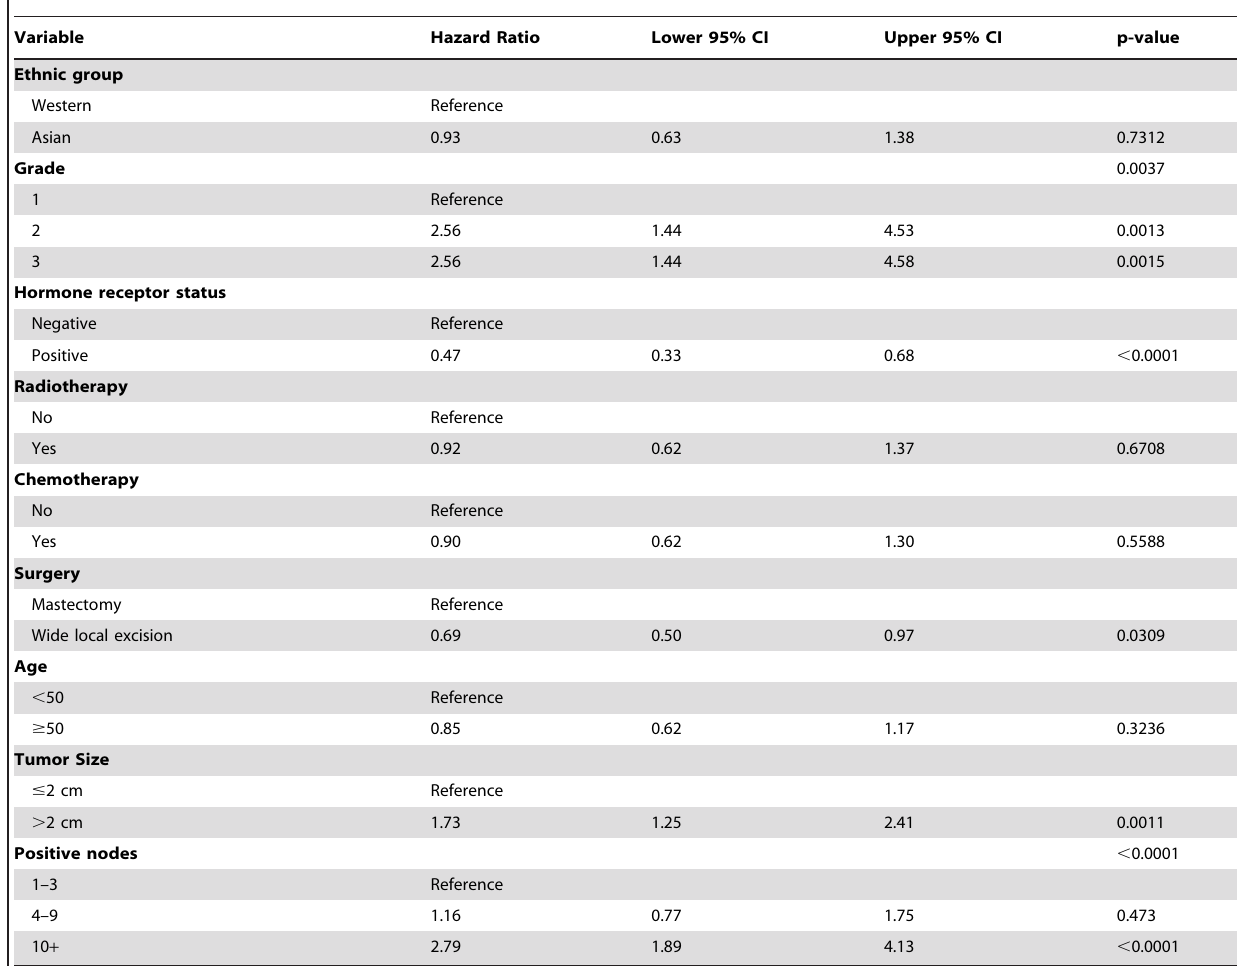
Table 3. Univariate analysis for disease-free